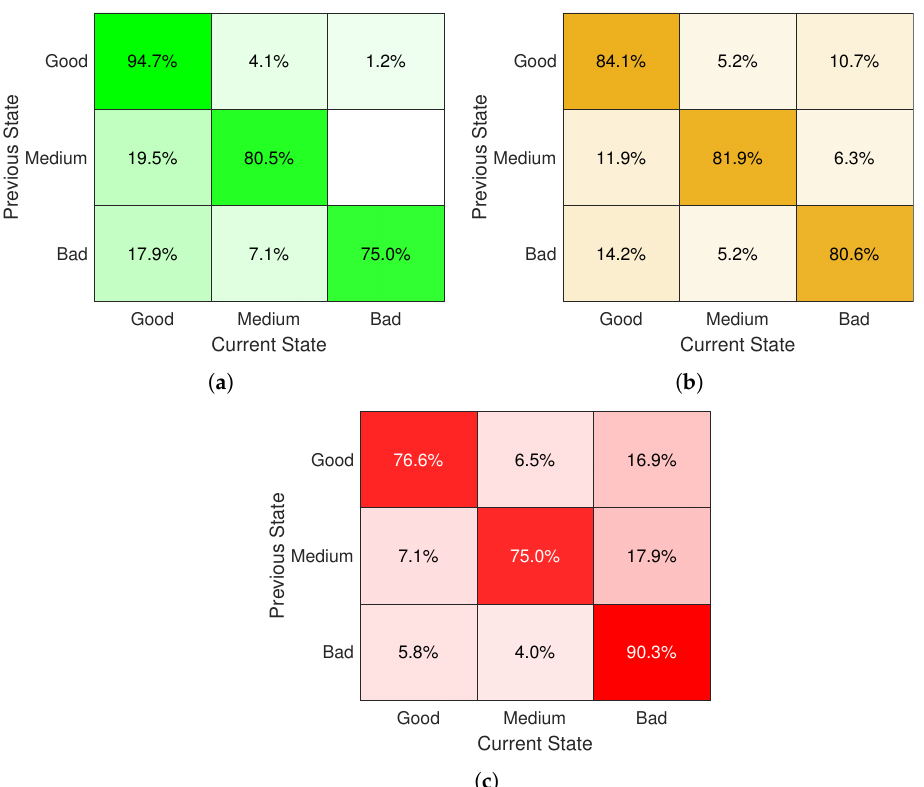
Figure 5. Examples of transition matrices: transition matrix P of the links from node 4 to node 2 observed in topology 2 ( a ), from node 3 to node 2 observed in topology 2 ( b ), and from node 1 to node 3 observed in topology 1 ( c